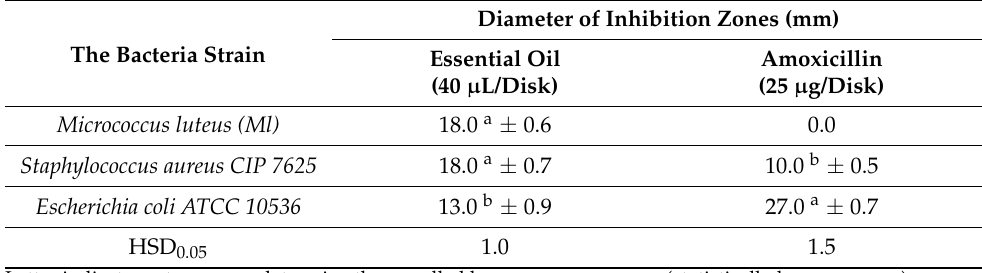
Table 13. Antimicrobial (Bacteria) activity of the essential oil using disc diffusion.